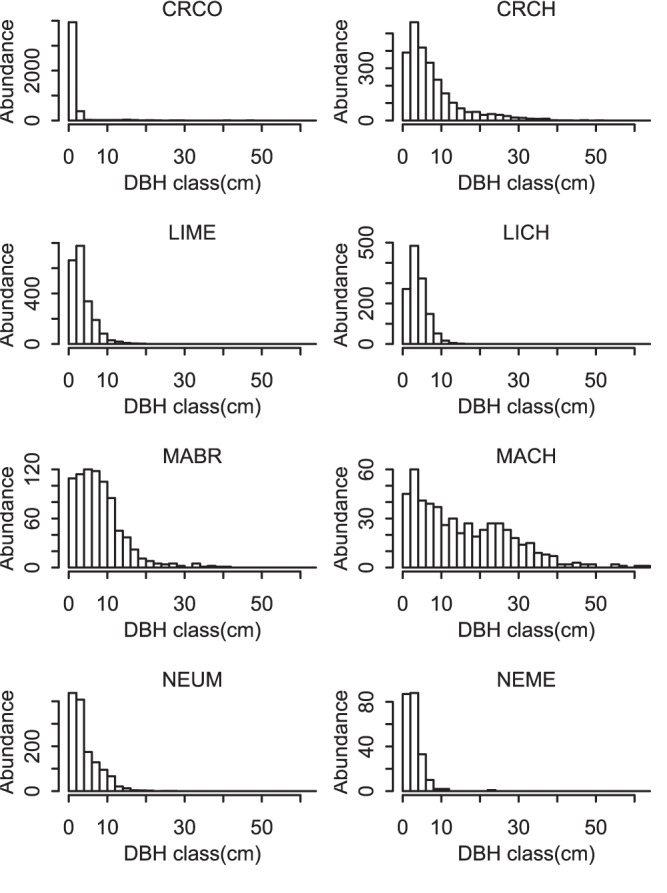
Size (DBH) class of the eight Lauraceae species belonging to four genera.